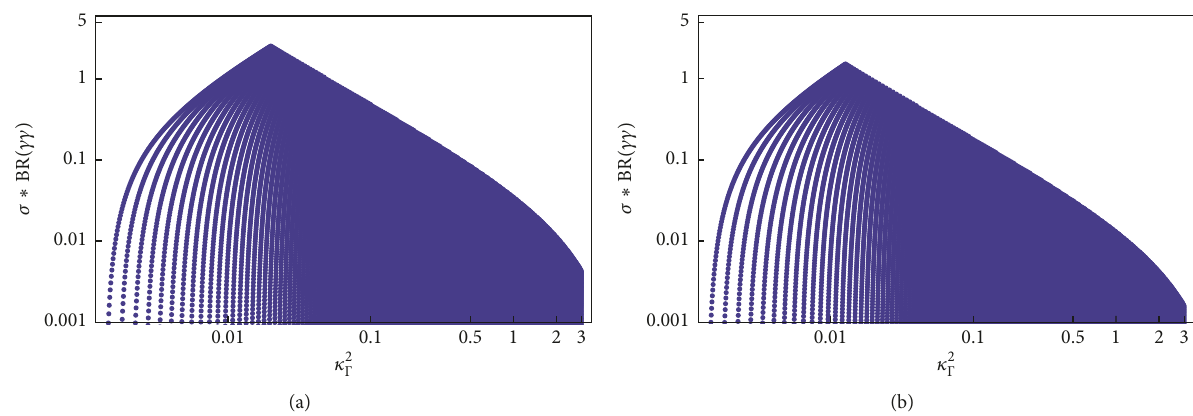
Figure 7: For the model of Section 2, 𝜎 휙 × BR 훾훾 (in fb) versus 𝜅 2 Γ , for 𝑀 휓 = 475 GeV and 𝑀 푈 = 1200 (a) and 1500 GeV (b), 𝑀 휙 = 1000 GeV, 𝑠 = 0.01 , and 𝑦 ,𝑦 ℎ 푈 휓 scanned over the range of